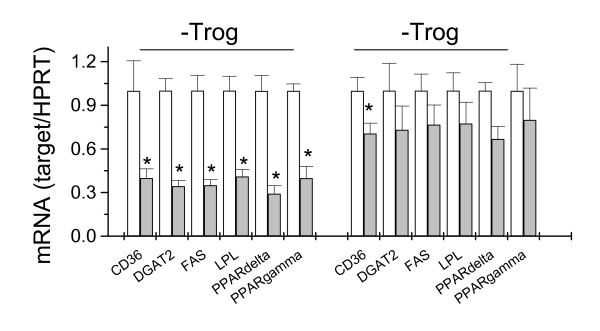
The effects of octanoate on expression of selected lipogenic genes and the antagonizing effects of troglitazone. Cells were incubated with octanoate (1 mM) for 24 h with or without troglitazone (5 μM), using DMSO as the vehicle. (Upper panel) The expression of CD36, diacylglycerol acyltransferase 2 (DGAT2), fatty acid synthase (FAS), and lipoprotein lipase (LPL) were analyzed by RT-qPCR using house keeping gene HPRT as the endogenous reference. The results were normalized to control cells. Results are mean +/- SE, n = 3, *p < 0.05.